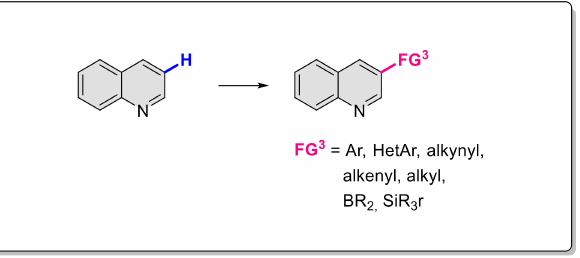
Scheme 37. Scope of the selective C-H functionalization achieved in position 3 to